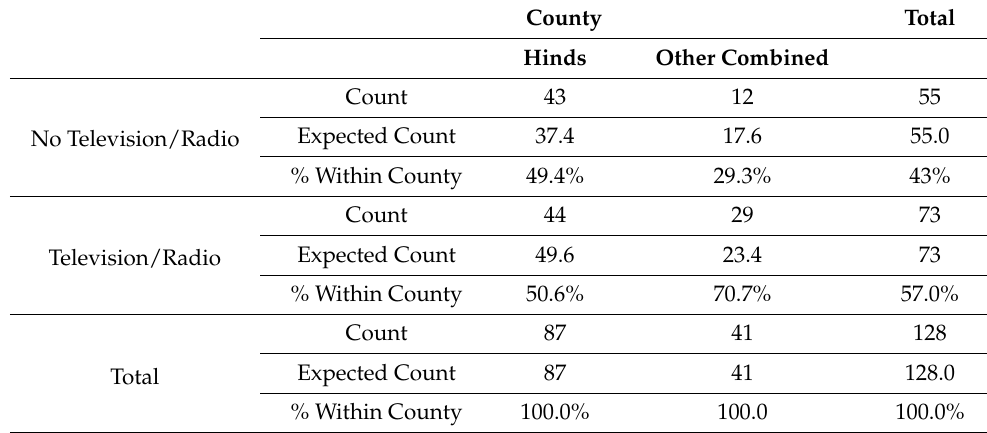
Table 2. Using television/radio to increase participation in community outreach activities by county of residence.